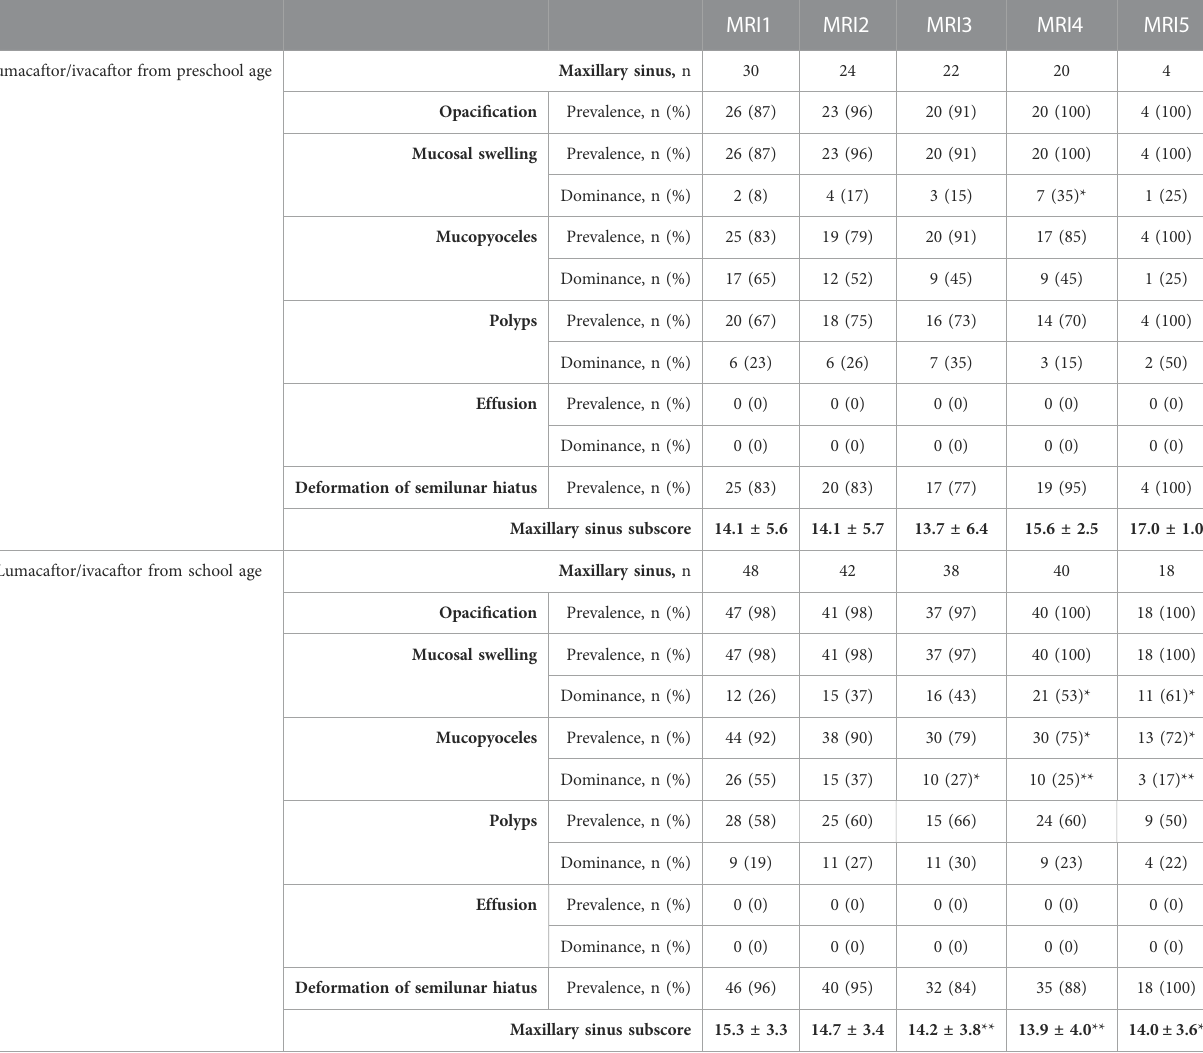
TABLE 2Chronicrhinosinusitis magneticresonanceimaging(CRS-MRI) scores for the maxillary sinusinchildrenwith cystic fi brosisbefore (MRI1)andafterstartof lumacaftor/ivacaftor therapy (MRI2-5) in preschool age or school age. Prevalence n (%) and dominance n (%) of sinus abnormalities are presented on a per-sinus basis, and sinus subscore as mean ± standard deviation. * p < 0.05 vs. MRI1, ** p < 0.01 vs. MRI1. For the frontal, sphenoid and ethmoid sinus please refer to Supplementary Table S4 –